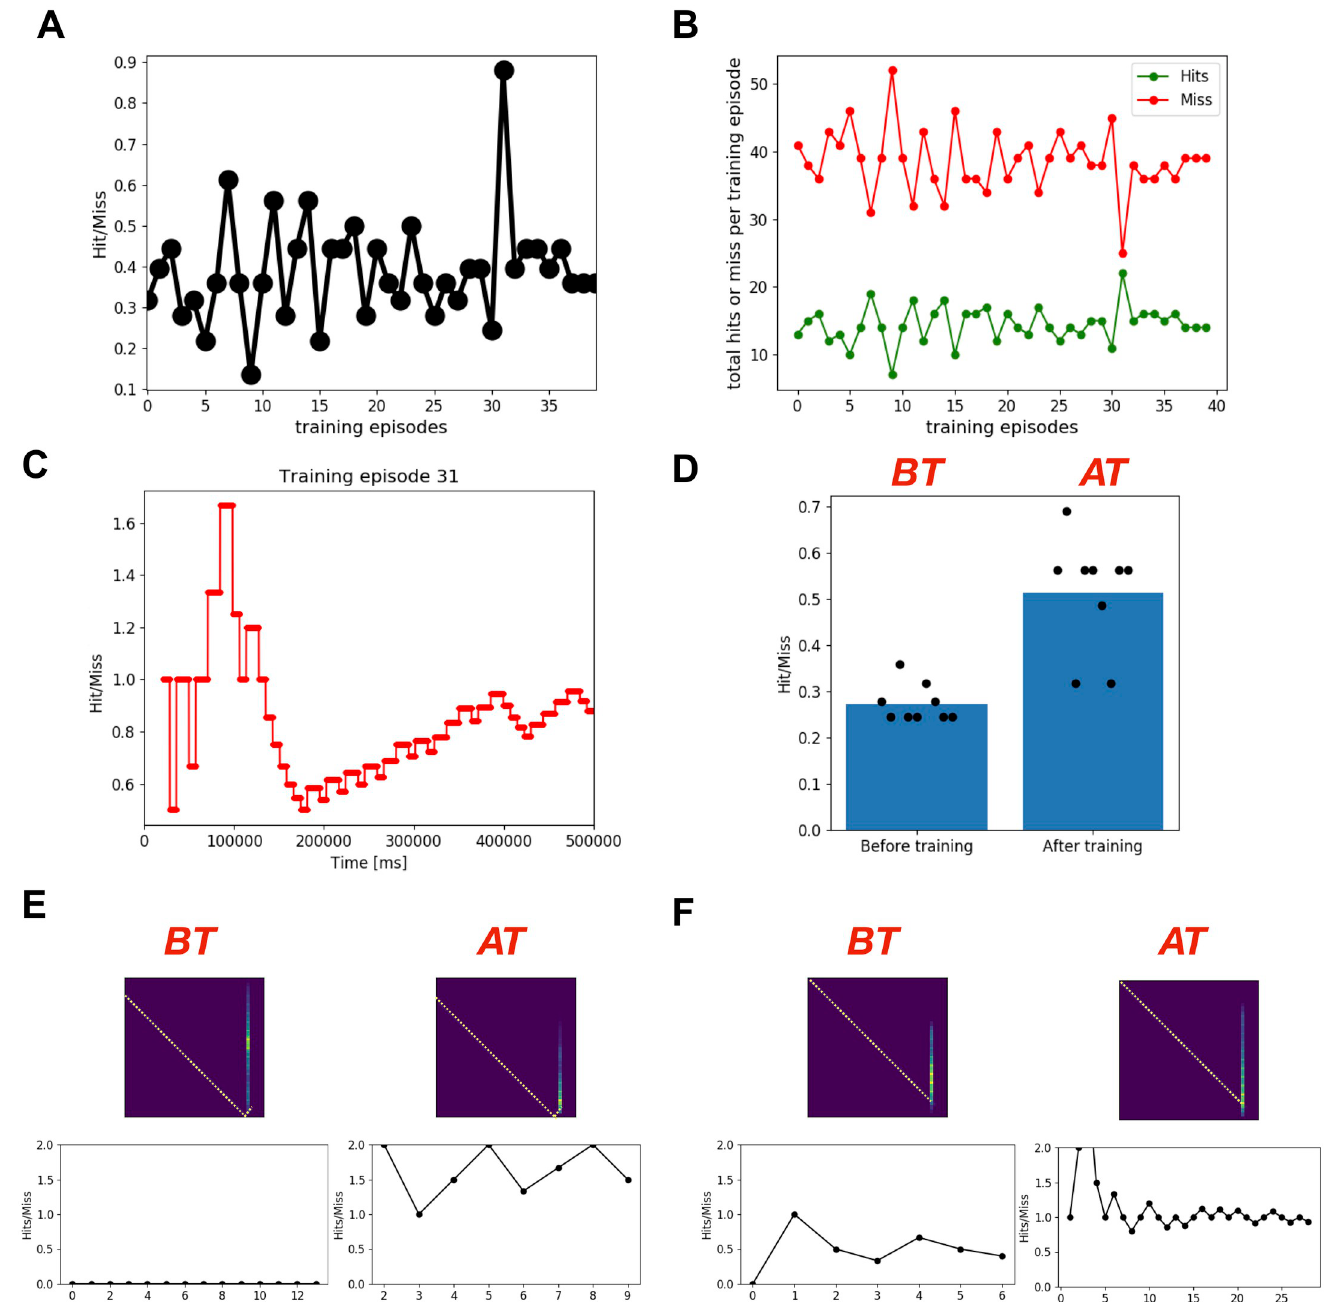
Fig 8. The recurrent model with sparse rewards shows sustained performance after learning. A) cumulative performance at the end of 40 training episodes. B) Cumulative Hits and Misses at the end of 40 training episodes. C) Temporal evolution of performance during training episode 31. D) Comparing performance of the model using weights from the end of training episode 31 (right) with the performance of the model before training (using initial weights; left). For both cases, the simulation was repeated 9 times each with different initial positions of the ball and the racket and the performance of each simulation is shown using black dots. The bar plot shows the average of those 9 simulations. E, F) Learning by the model is shown using two example ball trajectories. The left panels show the model’s performance for the repeated encounter of the ball trajectory when simulated using the initial synaptic weights (before learning). The right panels show the same as in the left panels but using the synaptic weights at the end of training episode 31 (peak performance AT in F is 3).